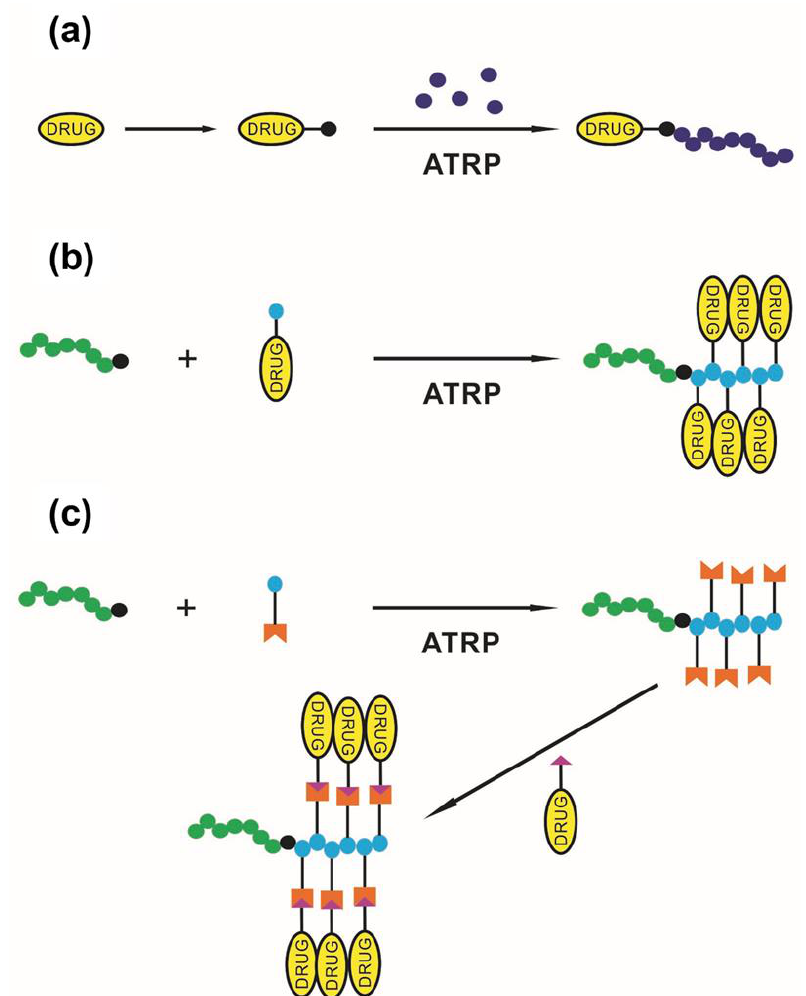
Figure 14. Three main strategies for obtaining covalently linked polymer – drug conjugates: ( a ) ac- tive substance as an ATRP initiator, ( b ) active substance as (meth)acrylate monomer, and ( c ) post- polymerization conjugation.